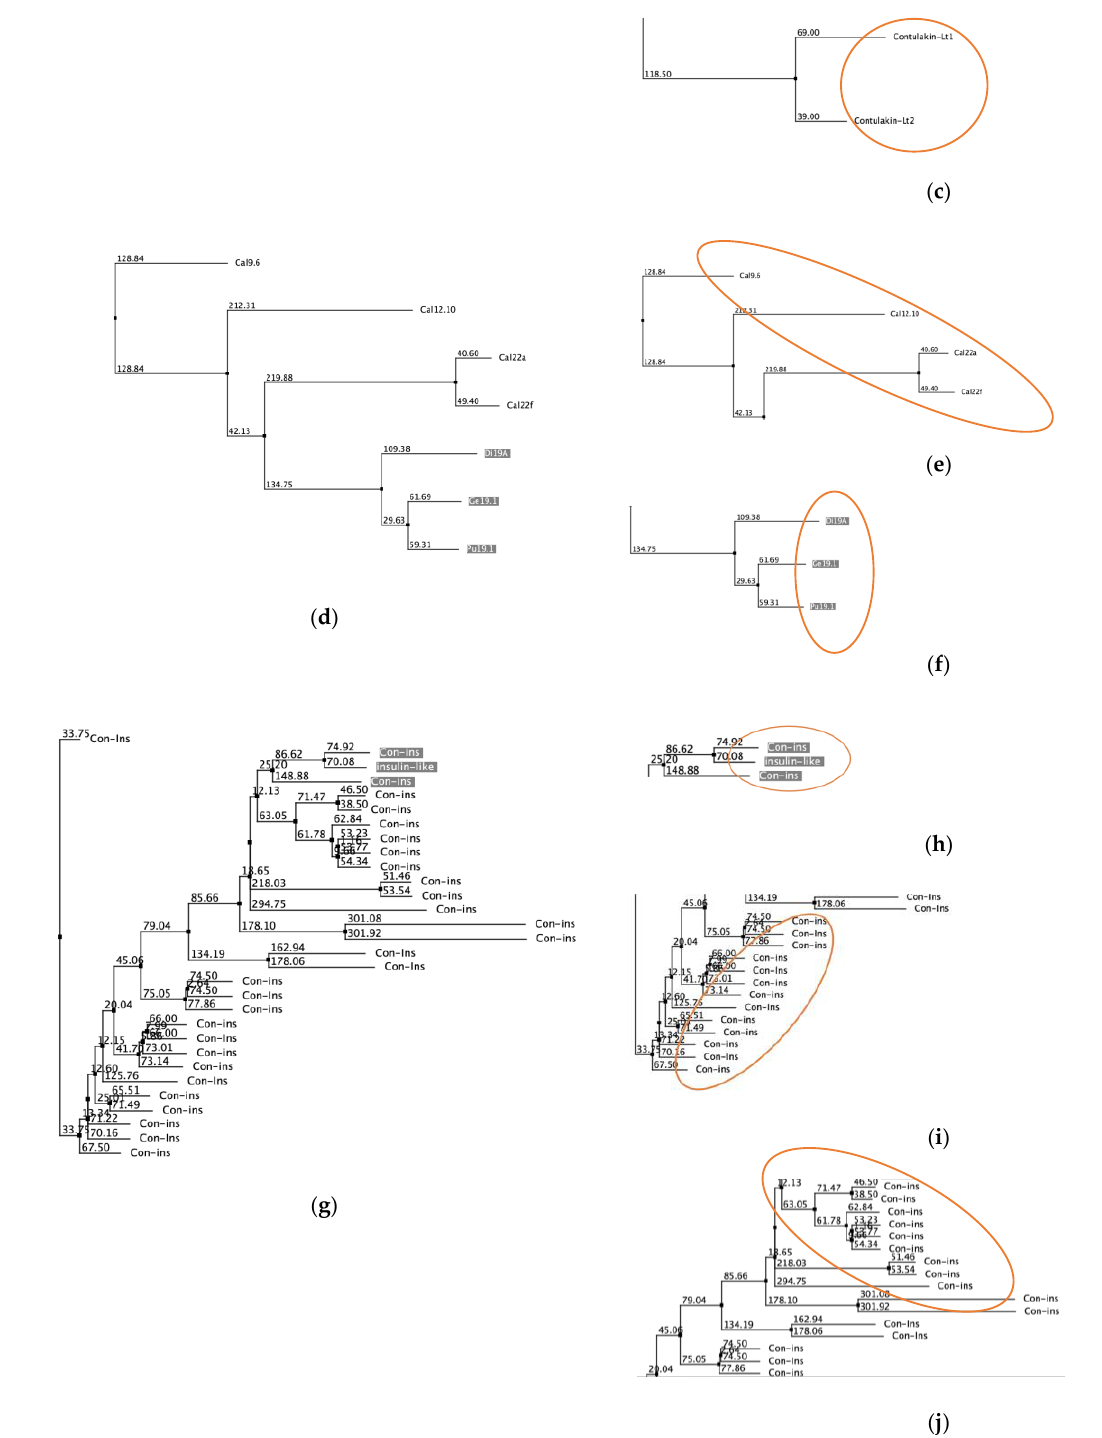
Figure 3. Neighbor-joining tree dendrograms. Each branch represents a single protein sequence. Sequences encircled represent the same diet types: ( a ) C superfamily (whole), ( b ) piscivorous C superfamily, ( c ) vermivorous C superfamily, ( d ) divergent-MSTLGMTLL superfamily (whole), ( e ) piscivorous divergent MSTLGMTLL, ( f ) vermivorous divergent MSTLGMTLL, ( g ) insulin superfamily, ( h ) molluscivorous insulin superfamily (whole), ( i ) piscivorous insulin superfamily, and ( j ) vermivorous insulin superfamily.